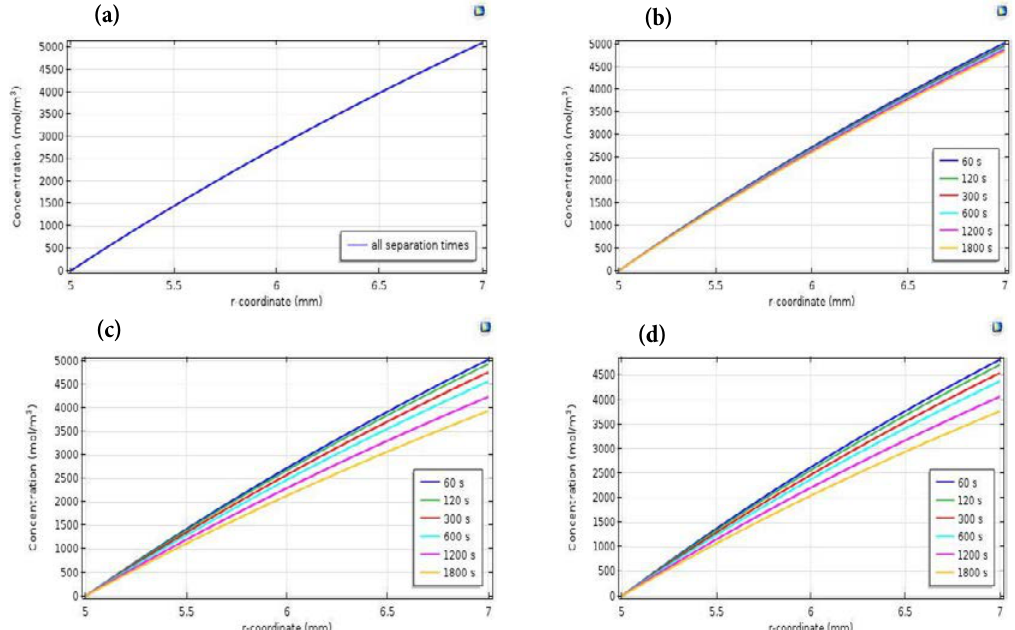
Fig. 15: Concentration distribution of water in membrane phase at different membrane lengths (0.5 l/min feed flow rate and 30°C temperature); (a) 5 mm, (b) 10 mm, (c) 20-90 mm and (d) 100